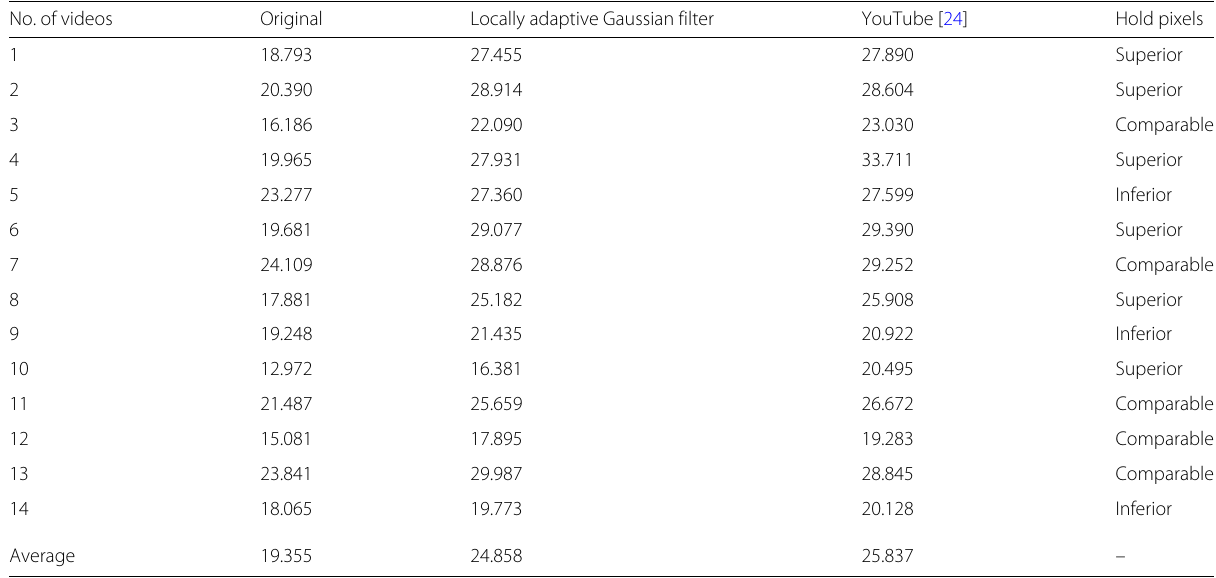
Table 4 Comparison between adaptive Gaussian filter and YouTube method [24] No. of